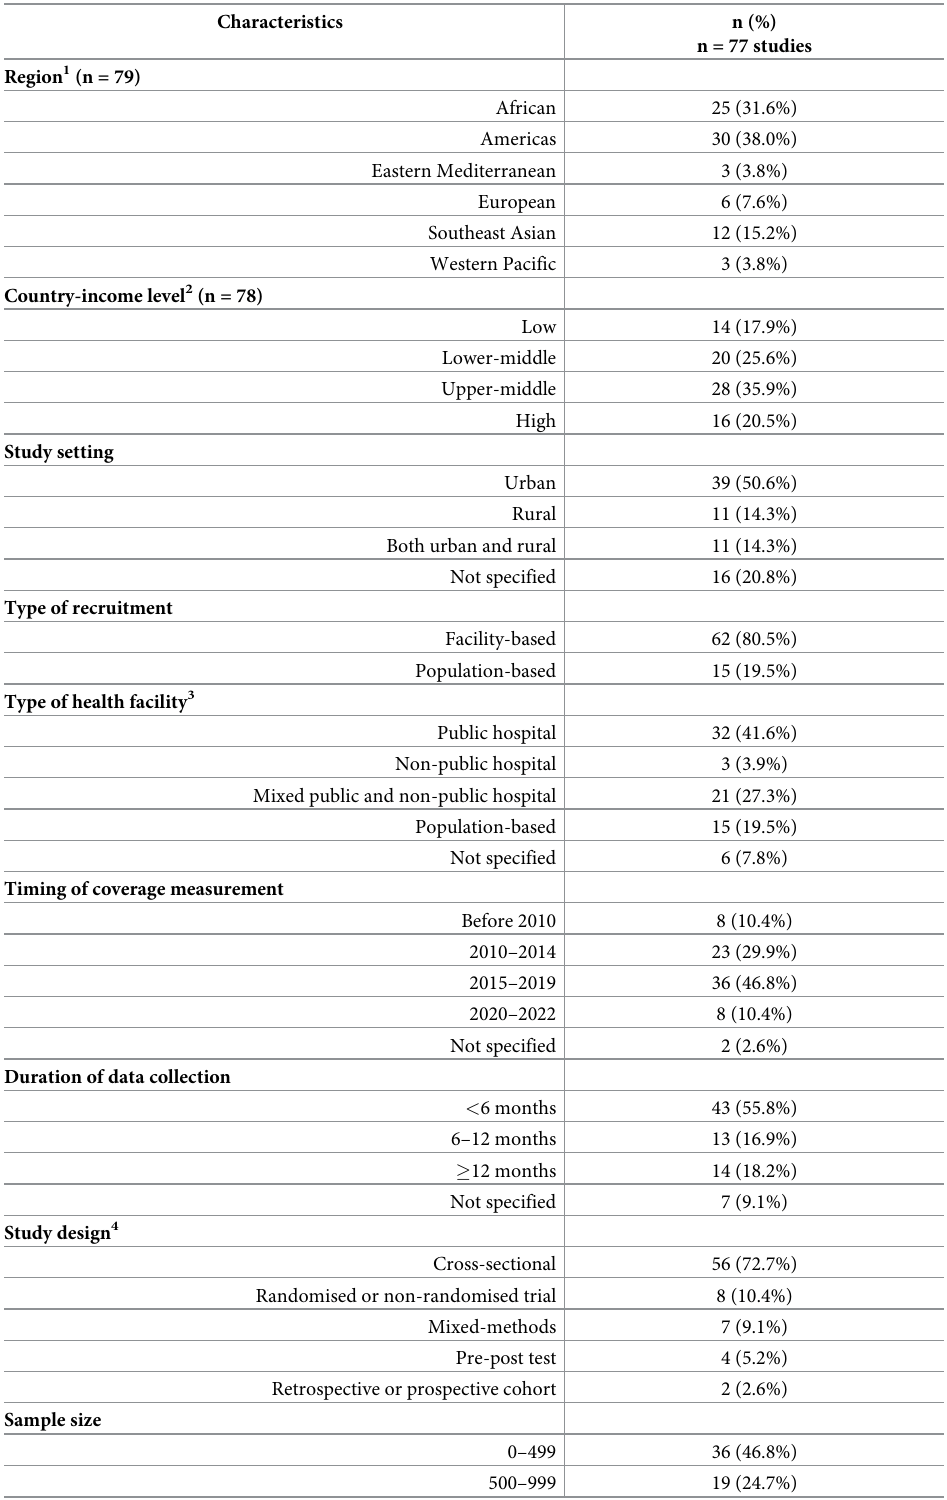
Table 1. Characteristics of included